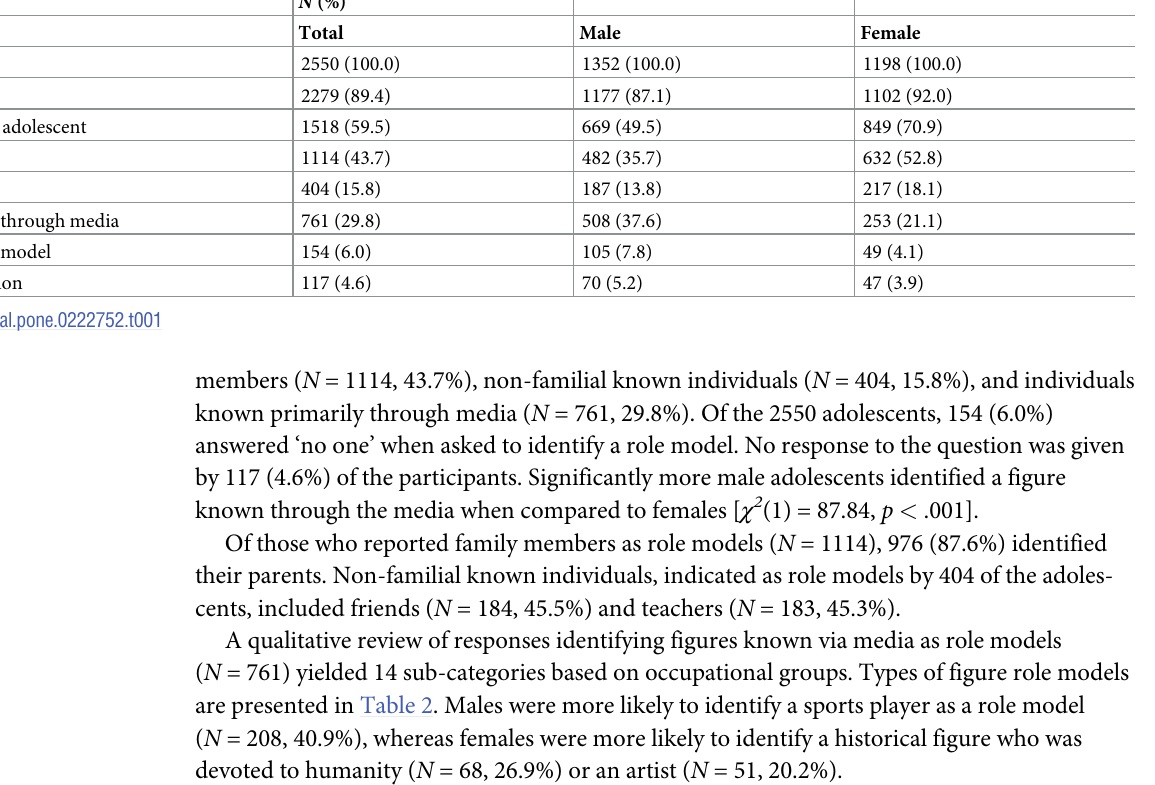
Table 1. Role model presence and type ( N = 2550).